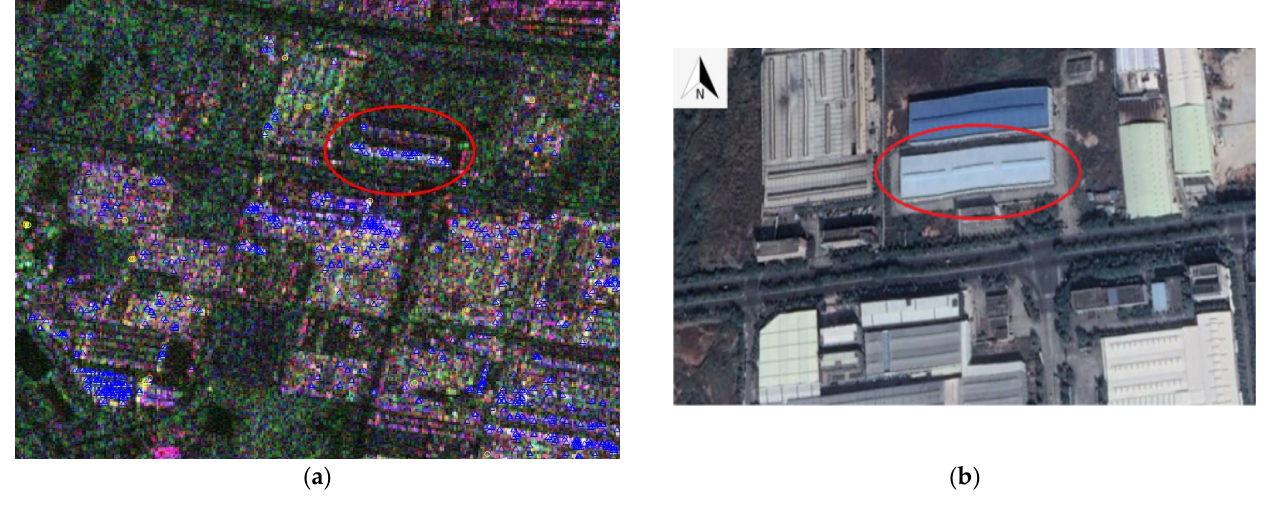
Figure 6. The 180-degree phase ambiguity determination process based on a specific building of this scene: ( a ) The local area of Figure 5b in the Jiangmen scene, the RDBs marked in blue triangles correspond to the left peak in Figure 5e, and the building circled in red is the target. ( b ) The optical image of the corresponding building on a Google image.